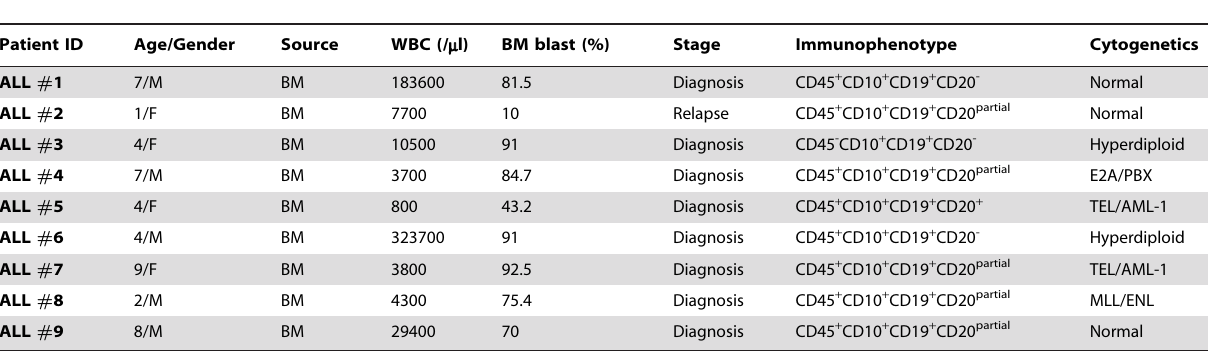
Table 1. Patient and leukemia